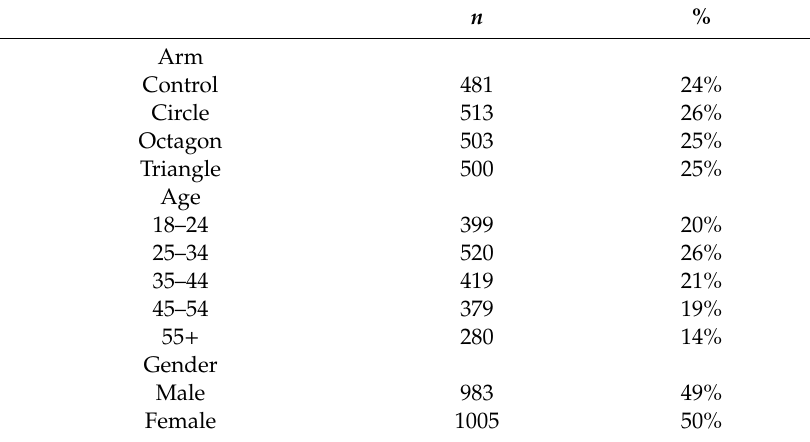
Table 1. Socio-demographic characteristics ( n =